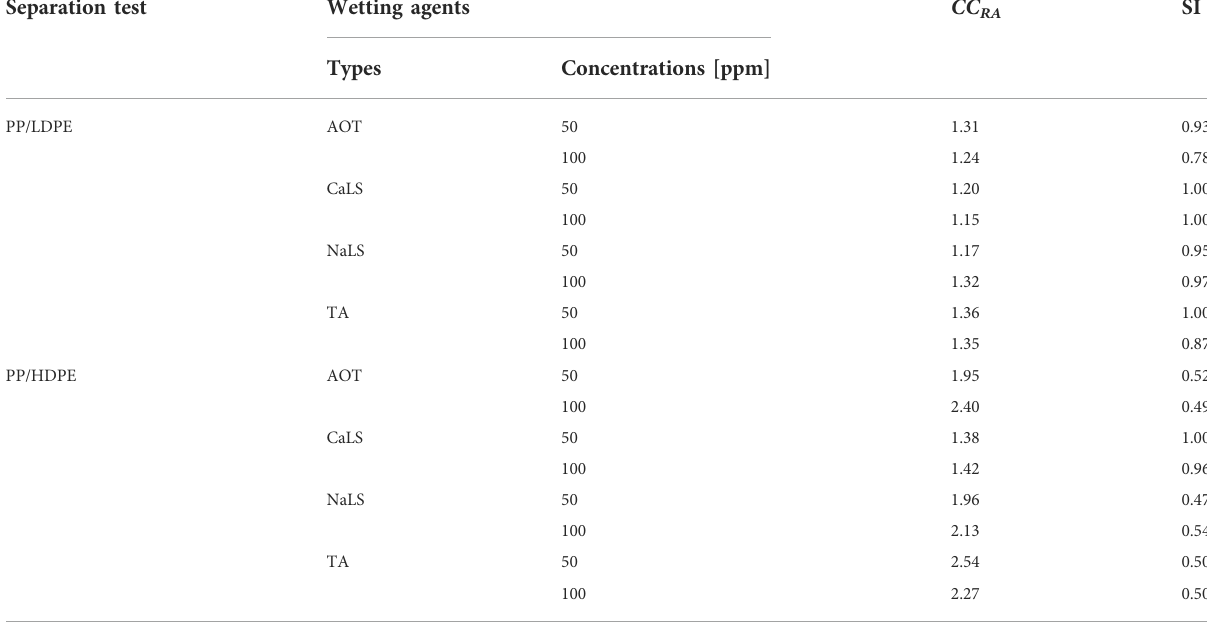
TABLE 2 Reverse apparent concentration criterion ( CC RA ) of each plastic mixtures (i.e., PP/LDPE and PP/HDPE) and sharpness index ( SI ) of reverse hybrid jig separation experimentswithout bubble generation during pulsation at different air fl ow rateof 1.0 L/min and wetting agents (i.e., AOT, CaLS, NaLS, and TA) of 50 and 100